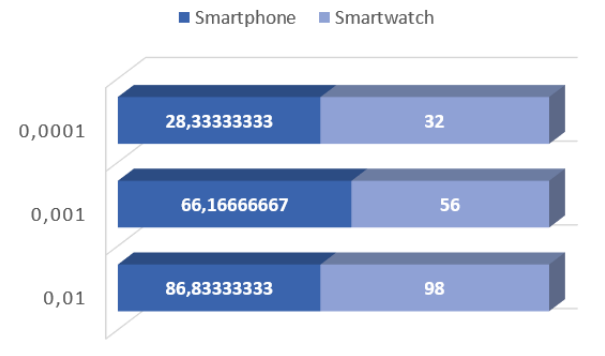
Figure 4. The value of prizes for the work (4 hidden layers) done in the proposed